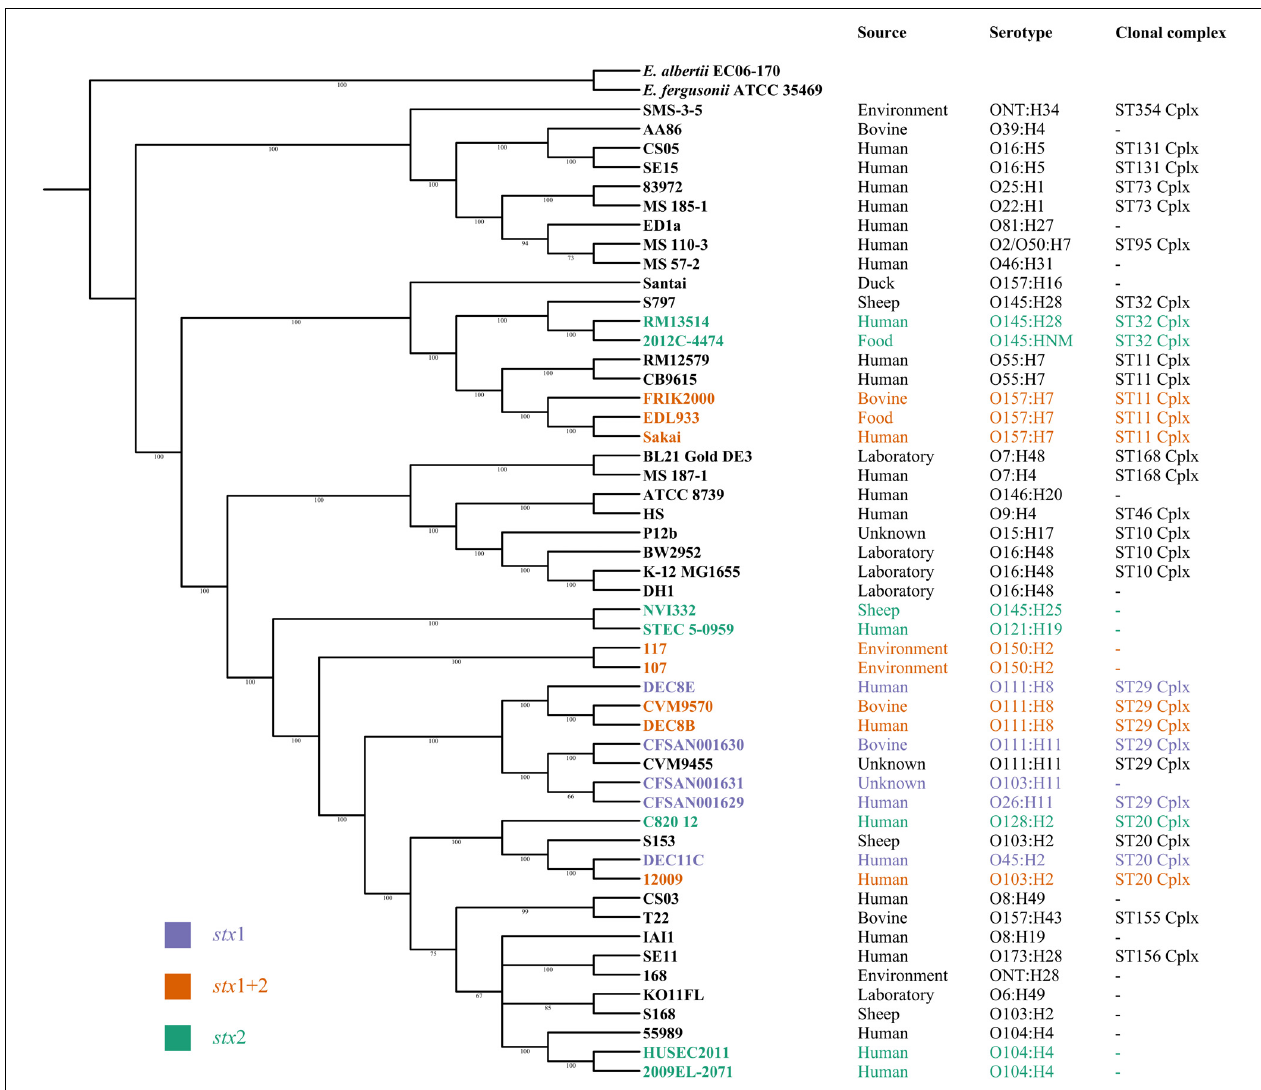
FIGURE 3 | Maximum likelihood tree illustrating the phylogeny of 51 E. coli reference strains based on the core genome alignment of 1193 genes. The distribution of STEC strains harboring stx 1 (purple), stx 2 (green) or stx 1 and stx 2 (orange) is color coded. Additionally, the source, serotype and MLST clonal complex are indicated for all E. coli